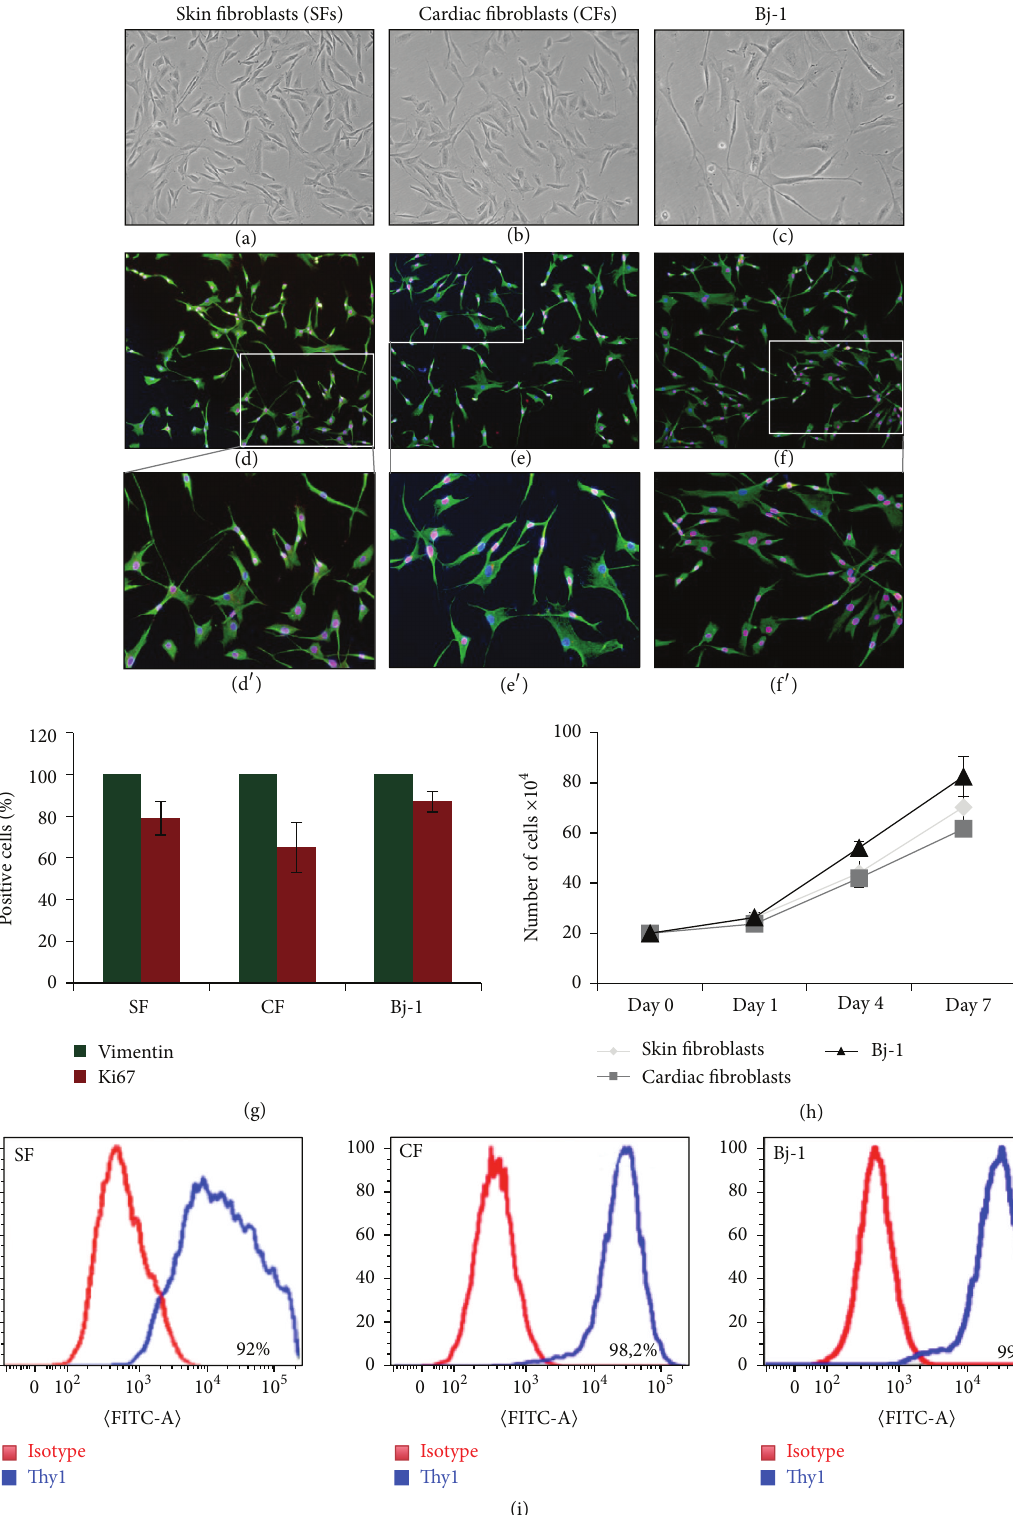
Figure 1: Canine primary culture characterization. Skin (a) and cardiac (b) canine fibroblasts showed similar morphology to human Bj-1 cells (c) and express in similar fashion Vimentin (in green) and Ki67 (in red) (d–f). The percentage of Vimentin and Ki67 positive cells was similar in the three cell populations (g). Growth curves of canine fibroblasts ( 𝑛 = 5 /fibroblast type) showed comparable proliferation ability with respect to Bj-1 fibroblasts (h). (i) Examples of FACS analysis revealing that canine fibroblast primary cultures highly expressed Thy1 (CD90), similarly to Bj-1